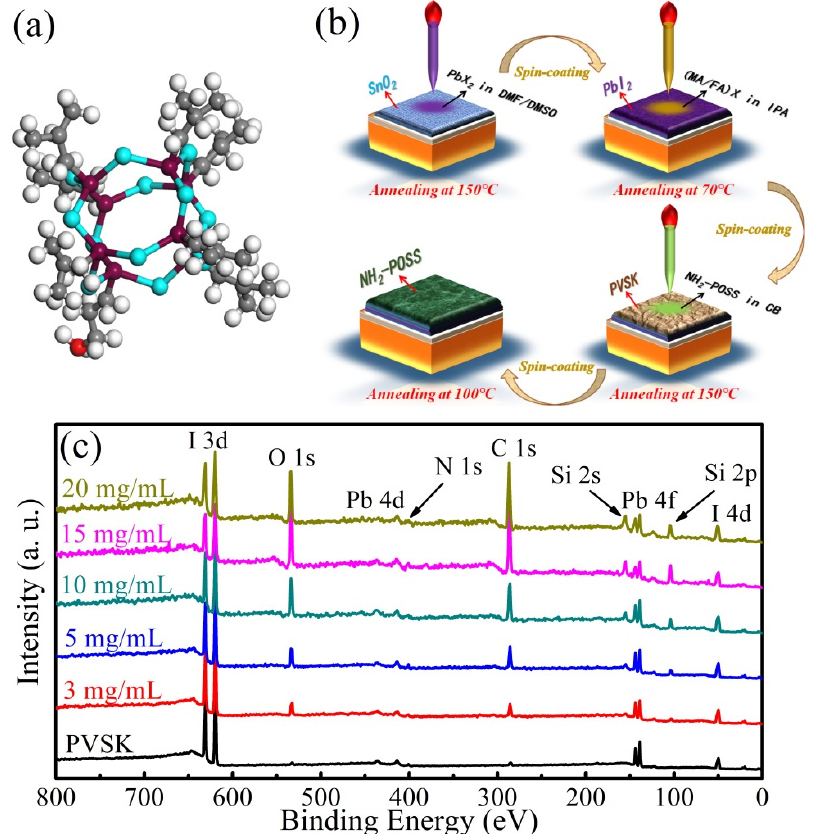
Figure 1. ( a ) The chemical structure of NH 2 -POSS. The presence of Si features is from NH 2 -POSS. ( b ) The schematic scheme of the surface modification process with NH 2 -POSS. ( c ) The XPS full-scan spectra of the perovskite films fabricated with different concentrations of NH 2 -POSS.